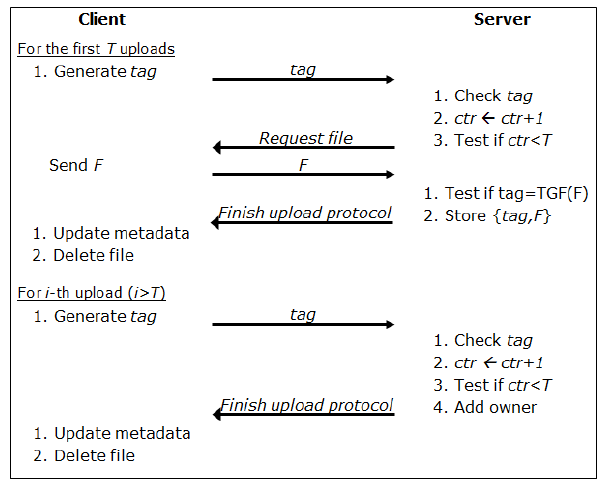
Figure 4. Counter-based client-side deduplication.